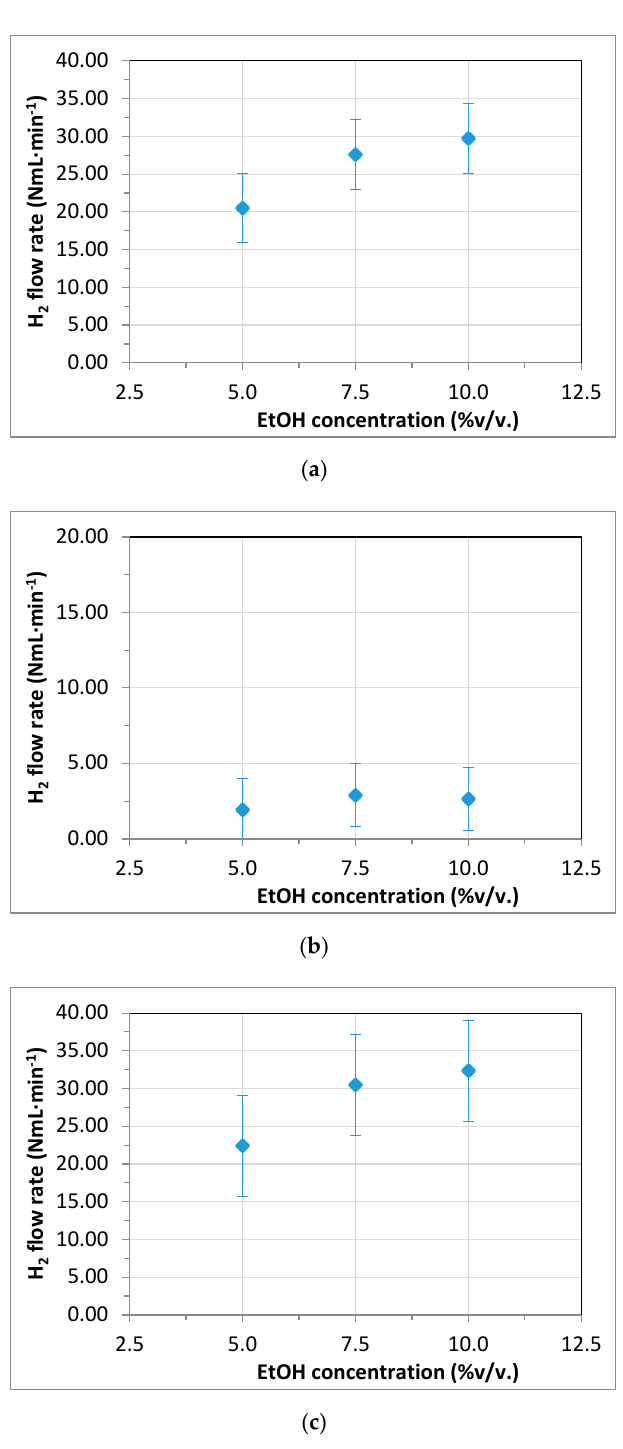
Figure 6. Effect of ethanol concentration in co-reforming experiments (T = 450 °C, P = 5.0 bar, feed: 15 Figure 6. E ff ect of ethanol concentration in co-reforming experiments (T = 450 ◦ C, P = 5.0 bar, feed: 15 g / h g/h mixture OMW–EtOH and 15 mL/min N 2 ): ( a ) permeate, ( b ) retentate, and ( c ) total produced mixture OMW–EtOH and 15 mL / min N 2 ): ( a ) permeate, ( b ) retentate, and ( c ) total produced hydrogen.